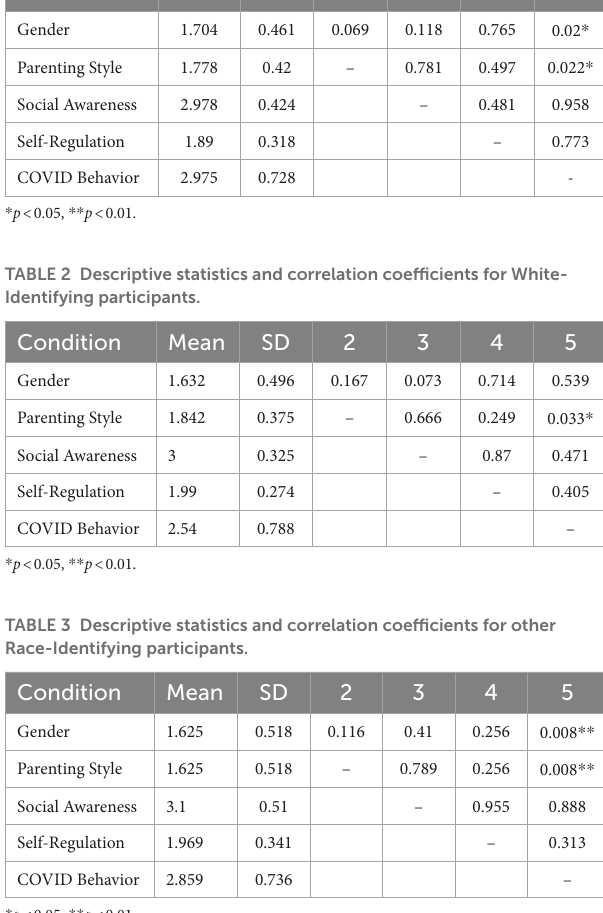
TABLE 4 Descriptive statistics and correlation coefficients for African American/Black-Identifying participants.